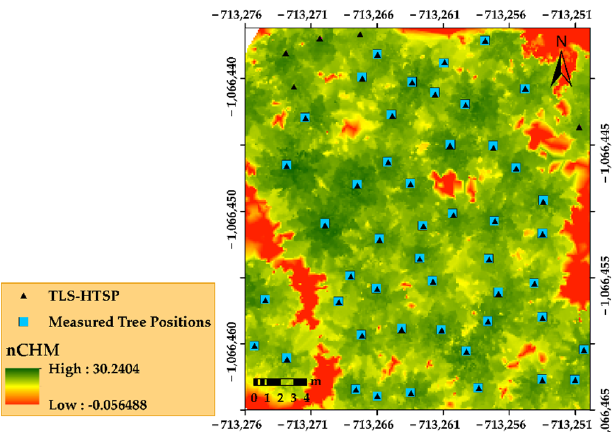
Figure 2. Normalized canopy height model (nCHM) and the stem locations. Unprocessed trees in the upper-left and -right corners are not part of this study.